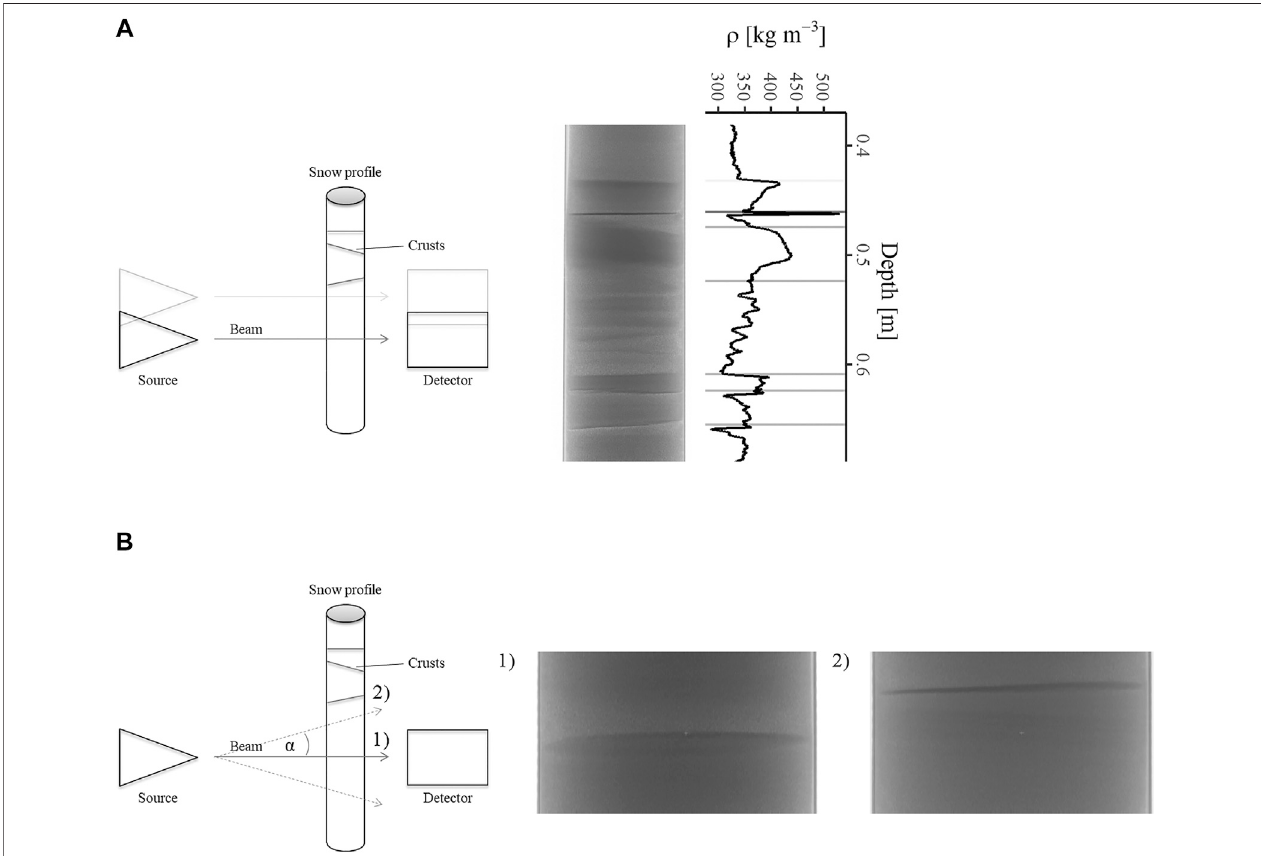
FIGURE2| Setupofthe μ CTtoretrieveadensitypro fi leandtodetectcrustsinasnowpro fi le. (A) Usingatransferfunction,thegrayvalueimageistranslatedintoa density pro fi le, only using records along the central radiographic line (solid gray arrow pointing from the X-ray source to the detector). Here, crusts are visible, but only if theyareorientedhorizontally.Densitypeaksatcrustscanbeseeninthedensitypro fi lenexttothegrayvalueimage. (B) Usingthenon-processedimages,weareableto look atsampleswithanangle ( α (cid:1) ± 16 ° )tothecentral radiographicline(graydotted lines).With thatmethod, also oblique crusts likeinpicture2) ontheright canbe detected. Angle 1) shows thecrust with a horizontal view (crust being just slighty visible),while angle 2) shows the crust with oblique view (crust becomes clearly visible).